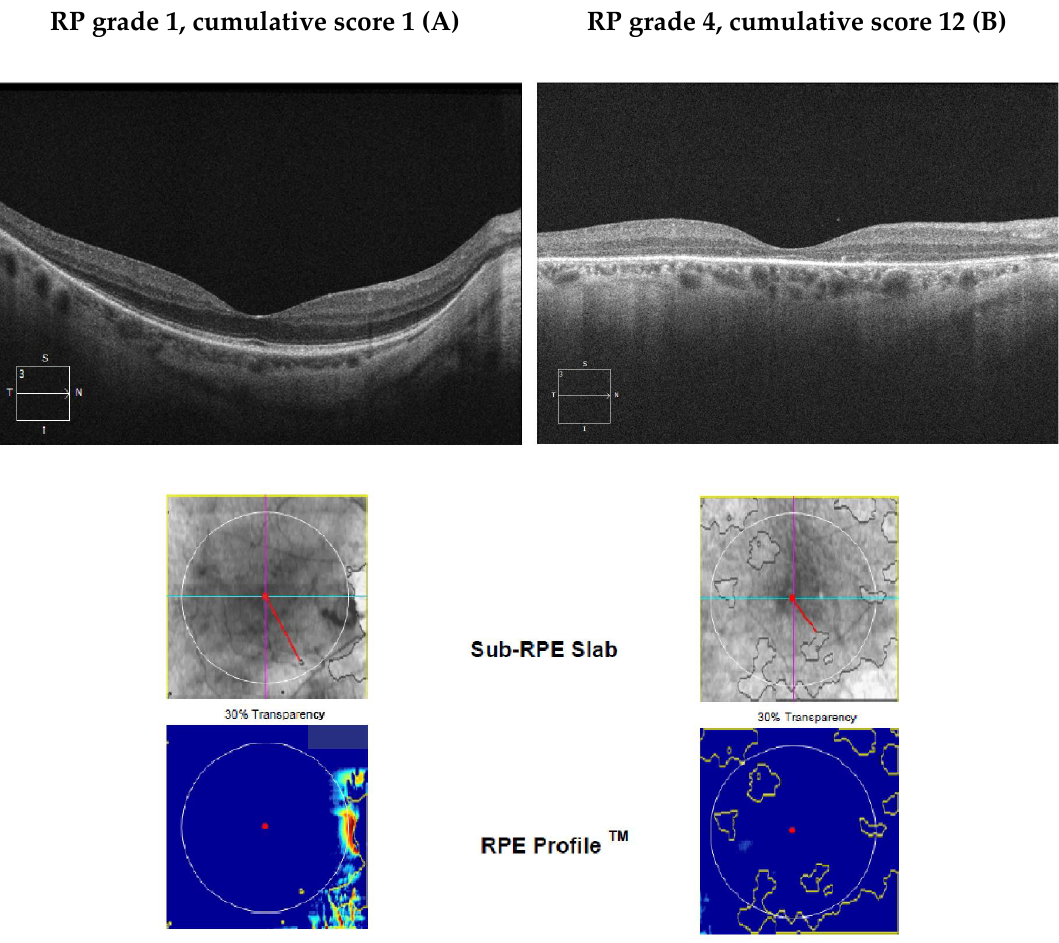
Figure 1. Images OCT B scan, sub-RPE slab and RPE profile of two patients with early stage RP ( A ) and advanced stage RP ( B ). In early stage RP ( A ), the ellipsoid zone is preserved in the foveal and parafoveal regions. In advanced RP ( B ) the almost complete loss of the ellipsoid zone and marked reduction in the outer nuclear layer are observable.